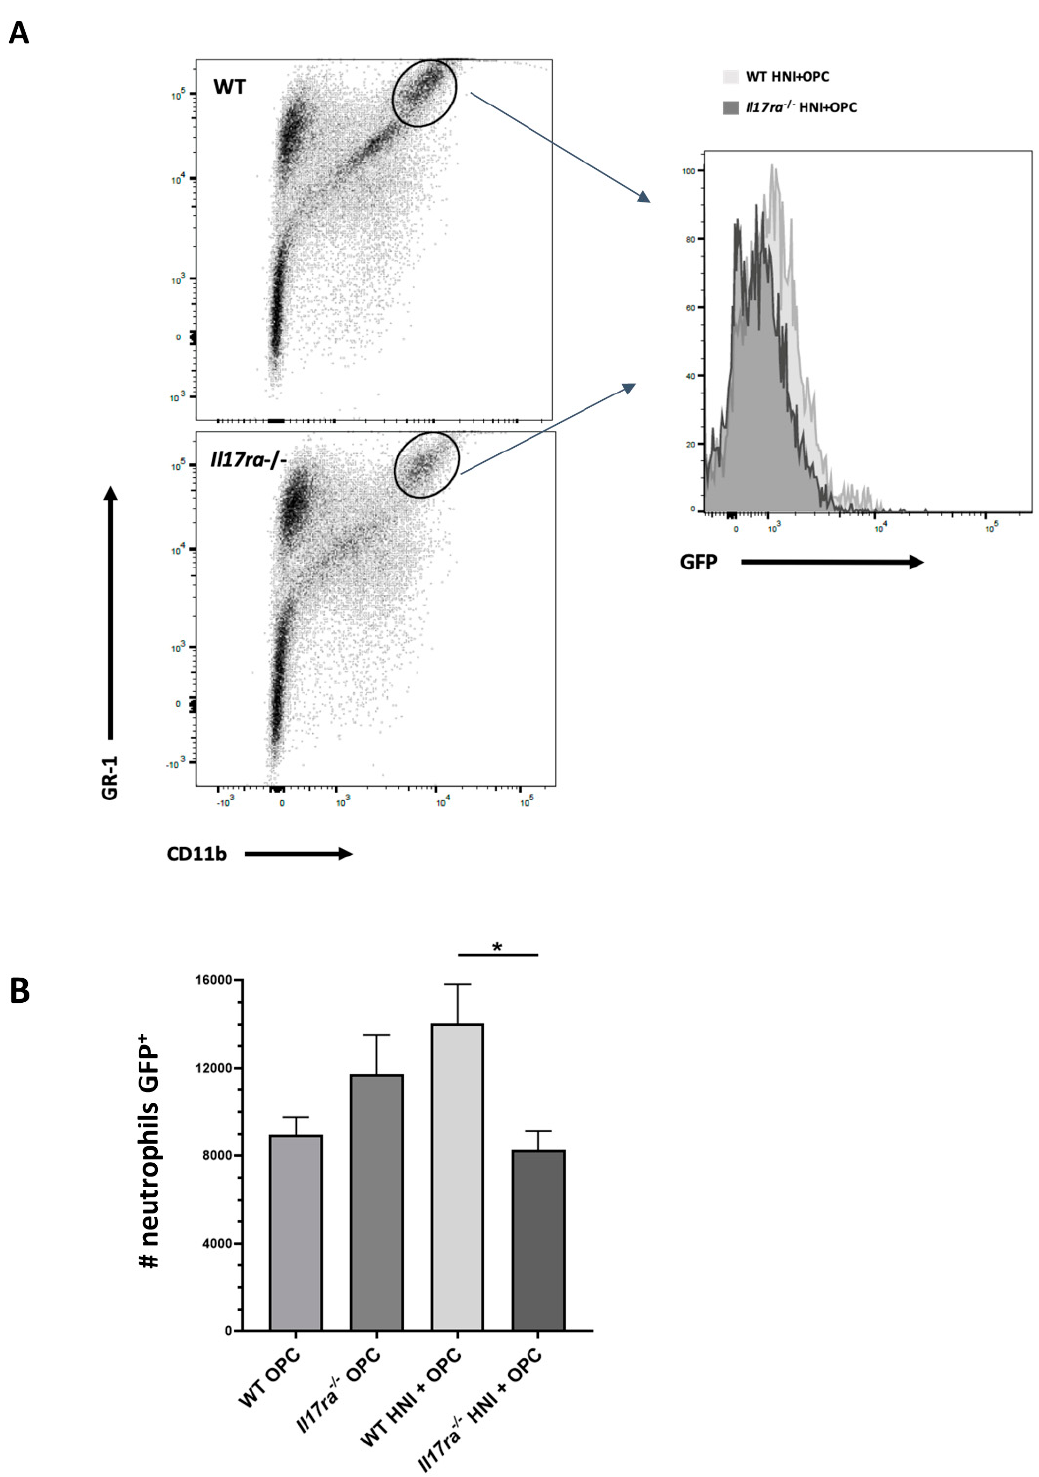
Figure 10. Decreased phagocytic activity by neutrophils in IL-17RA-deficient mice in response to OPC after HNI. ( A , B ) Flow cytometry was performed on whole tongues harvested Day 4 after exposing mice to OPC and HNI +OPC with a GFP-expressing Candida albicans strain. Data represent the number of GR1 + CD11b+ neutrophils positive for GFP. Analyzed by one-way ANOVA with Tukey’s post hoc. (n = at least 3 mice per group). (* p < 0.05). Data represent 2 experimental repeats. (Saul-McBeah et al. 2022).